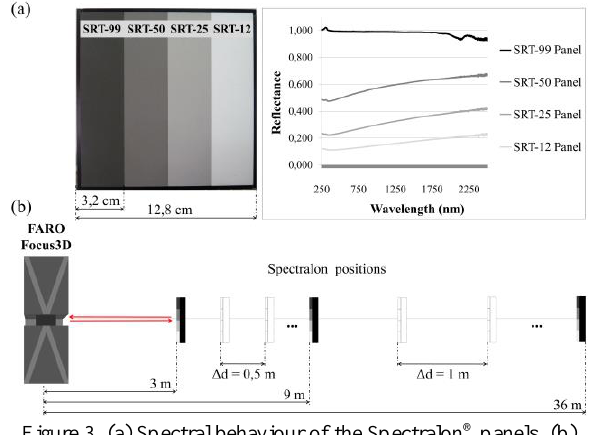
Figure 3. (a) Spectral behaviour of the Spectralon ® panels. (b) Sketch of the Faro Focus3D data acquisition